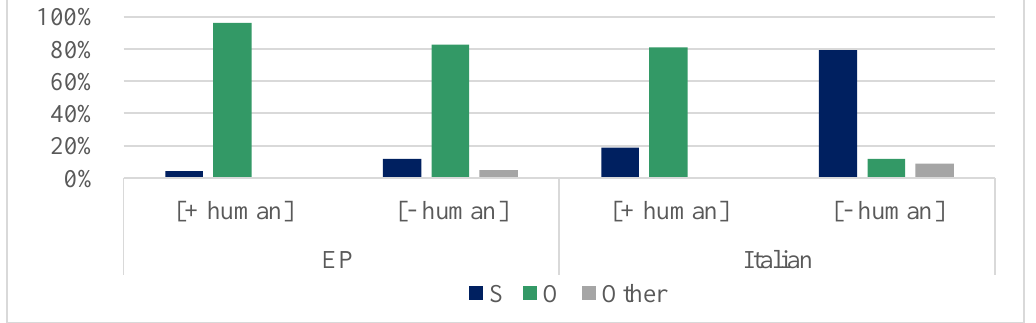
Figure 2. Interpretation of the overt pronominal subject in the untimed